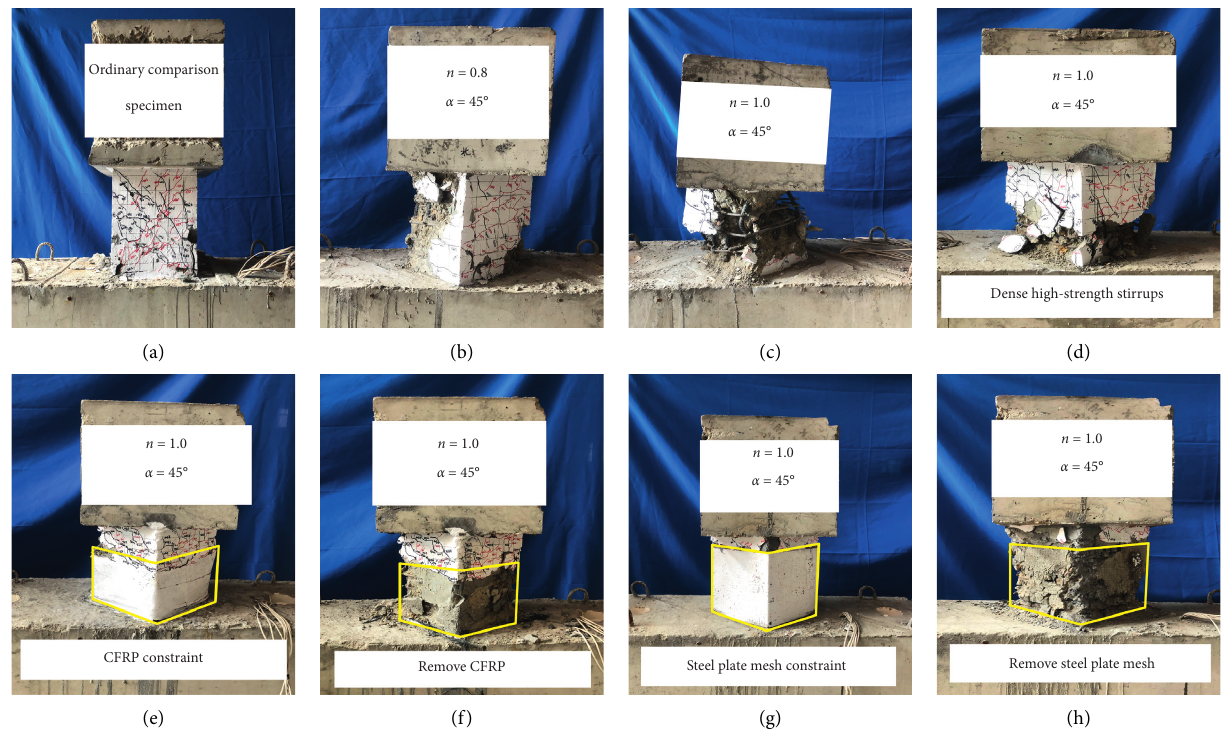
Figure 6: Visual observations of the ultimate failure modes of short column (SC) specimens. (a) SC-1, (b) SC-2, (c) SC-3, (d) SC-4, (e) SC-5, (f) SC-5 after removal of CFRP, (g) SC-6, and (h) SC-6 after removal of steel plate